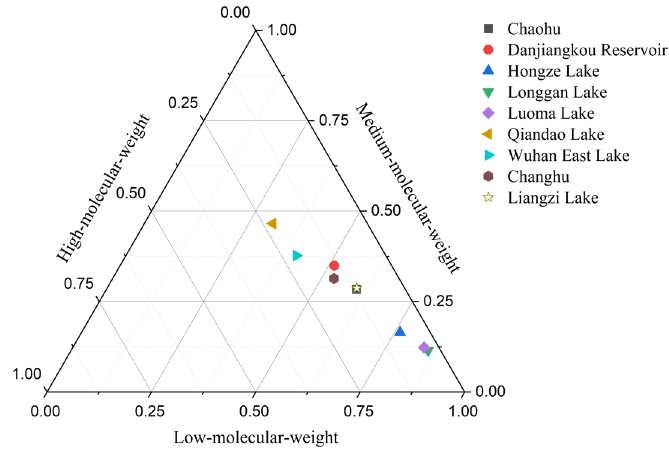
Figure 3. Composition of low-, medium- and high-molecular-weight PAHs in soil.